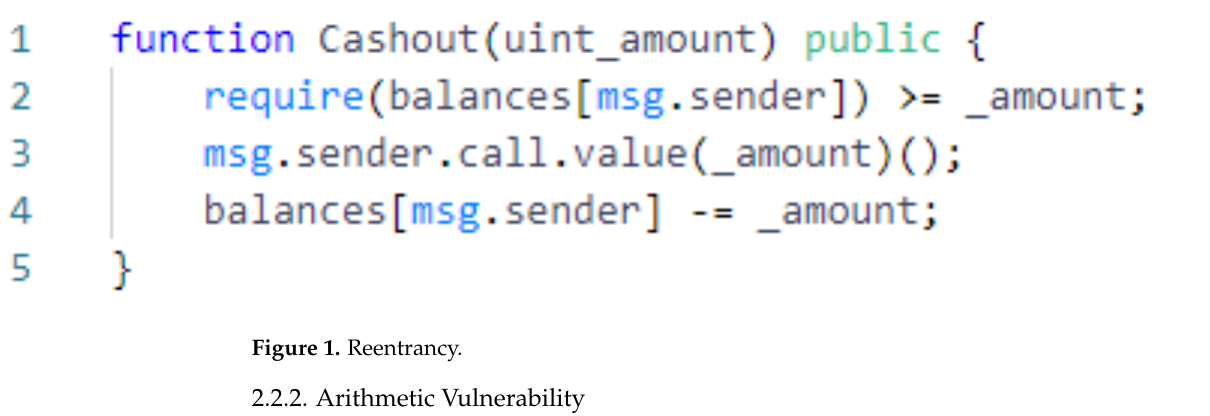
Figure 1. Reentrancy. Figure 1.